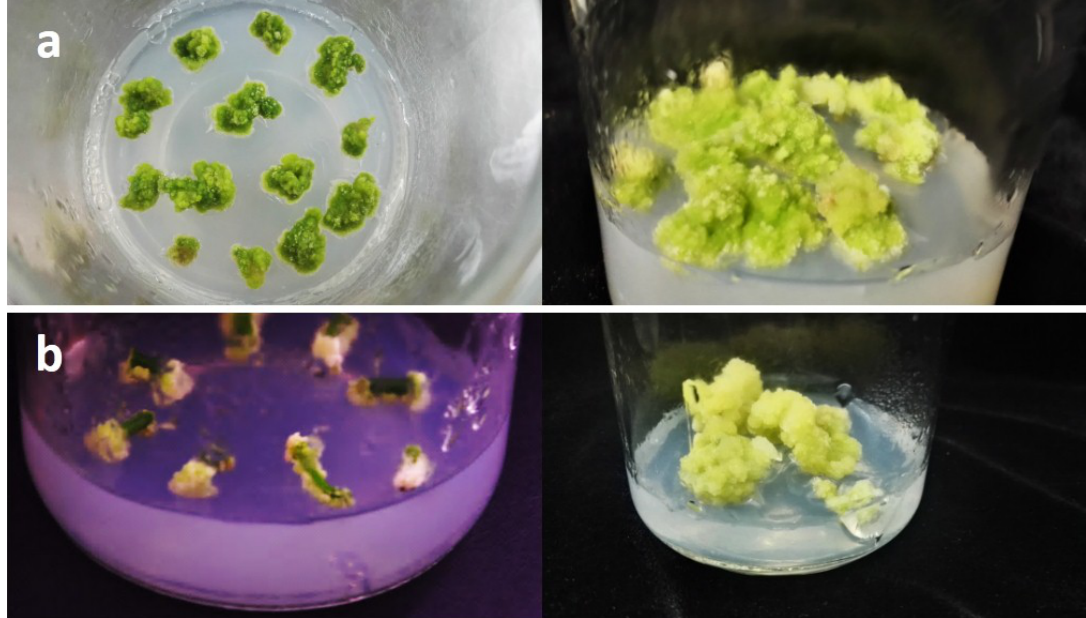
Figure 1. Massive production of callus from stem explants of ( a ) J. sambac and ( b ) J. mesnyi on WPM medium supplemented with 0.2 mg/L NAA + 2 mg/L 6-BA ( a , b ) after 14 days in culture .